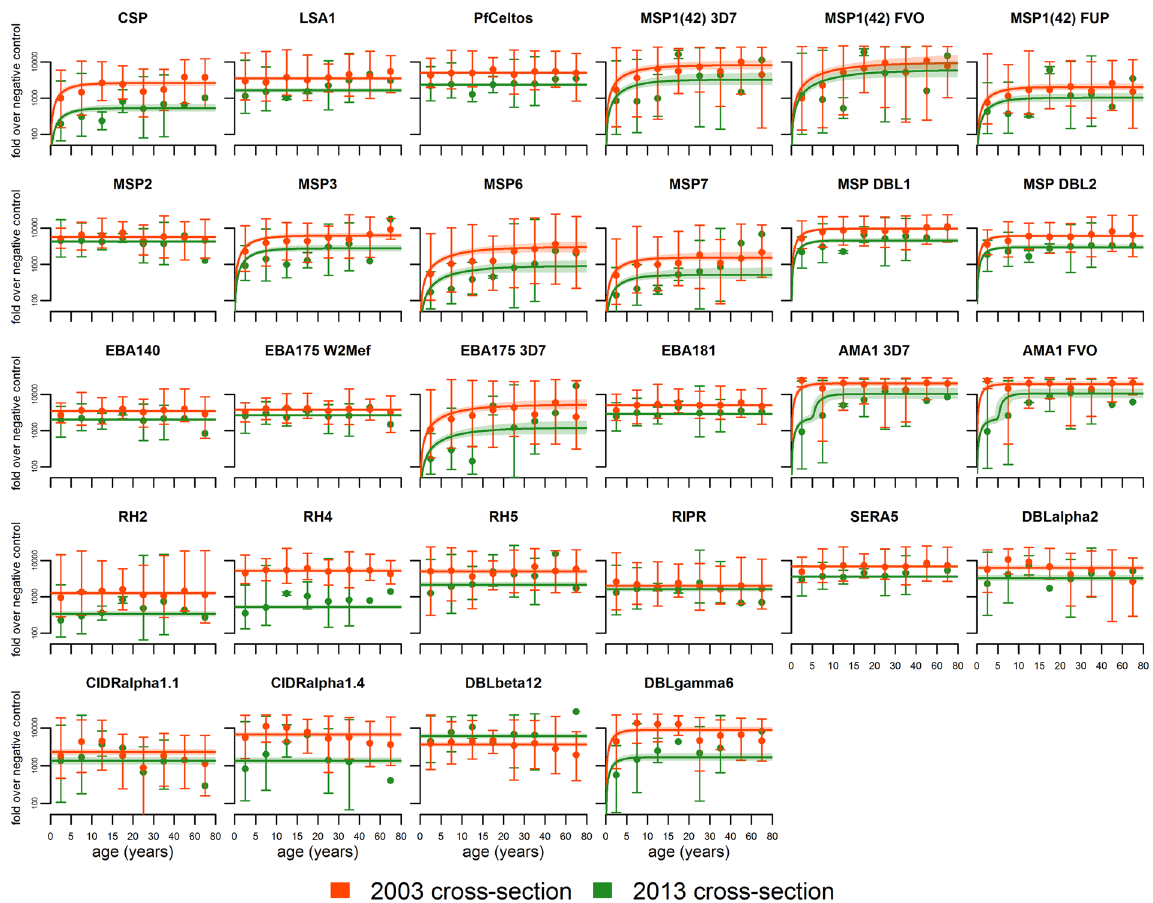
Figure 3. Age-related geometric mean antibody levels for 28 Plasmodium falciparum antigens in 2003 and 2013 antigens. A multiplexed antibody assay was performed using recombinant antigens conjugated to microsphere beads as described previously 45 . Mean fluorescent intensity (MFI) values obtained from the assay were divided by the average MFI of malaria naïve North American controls. Results are expressed as the geometric fold- increase of study participant MFI relative to the MFI of malaria naïve controls. The data are presented as geometric mean antibody levels with 95% ranges in different age bins. Continuous lines represent the best model fit. The shaded areas denote the 95% credible interval of the model